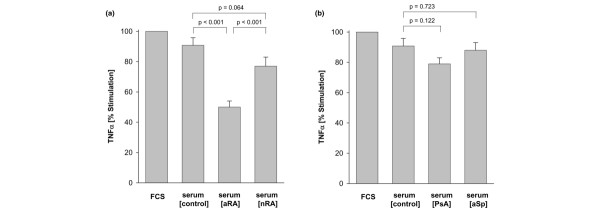
Inhibition of T cell-induced TNF-α production by monocytes is specific for active RA. (a) Preactivated peripheral-blood T cells (106/ml; see Materials and methods) were fixed and incubated for 24 hours with freshly isolated peripheral-blood monocytes (1.5 × 106/ml) at a ratio of 7:1. The co-incubation assay was performed in the presence of 10% FCS, 10% serum from healthy donors (serum [control], n = 10), from patients with active RA (serum [aRA], n = 20) or from patients with non-active RA (serum [nRA], n = 20). All data are expressed as percentages of TNF-α produced in the co-culture system containing 10% FCS. Data are means ± SEM; levels of significance are as indicated. (b) Co-incubation assays (see (a)) were performed in the presence of 10% FCS, 10% serum from healthy donors (serum [control], n = 10)), serum from patients with psoriatic arthritis (serum [PsA], n = 9) or from patients with ankylosing spondylitis (serum [aSp], n = 9). All data are expressed as percentages of TNF-α produced in the co-culture system containing 10% FCS. Data are means ± SEM; levels of significance are as indicated.